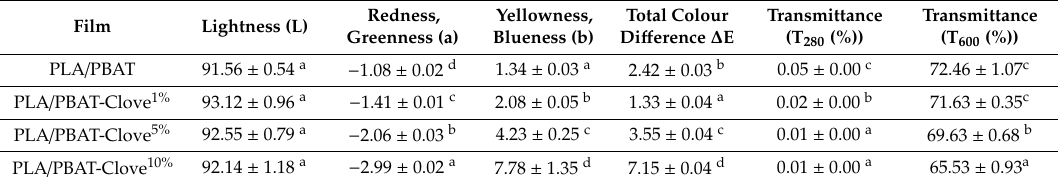
Table 2. Surface colour, UV barrier and transparency of composite films with Clove